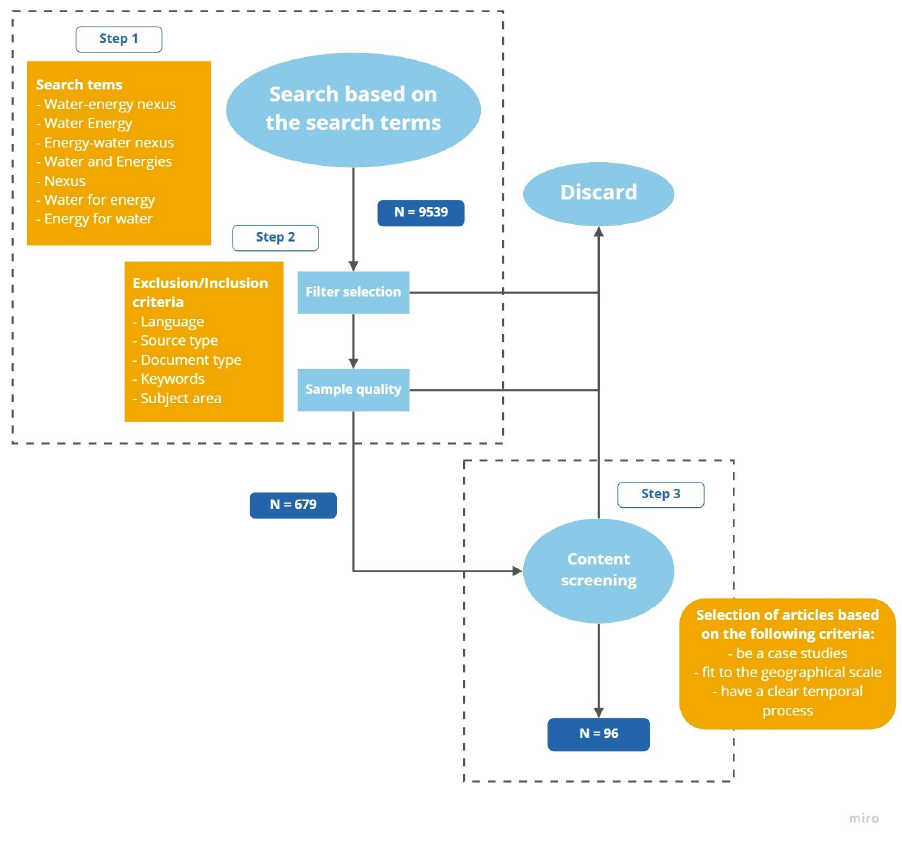
Figure 2. Literature review